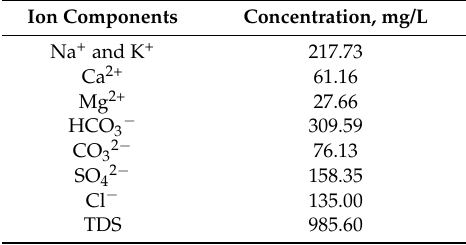
Table 2. Ion component concentrations in